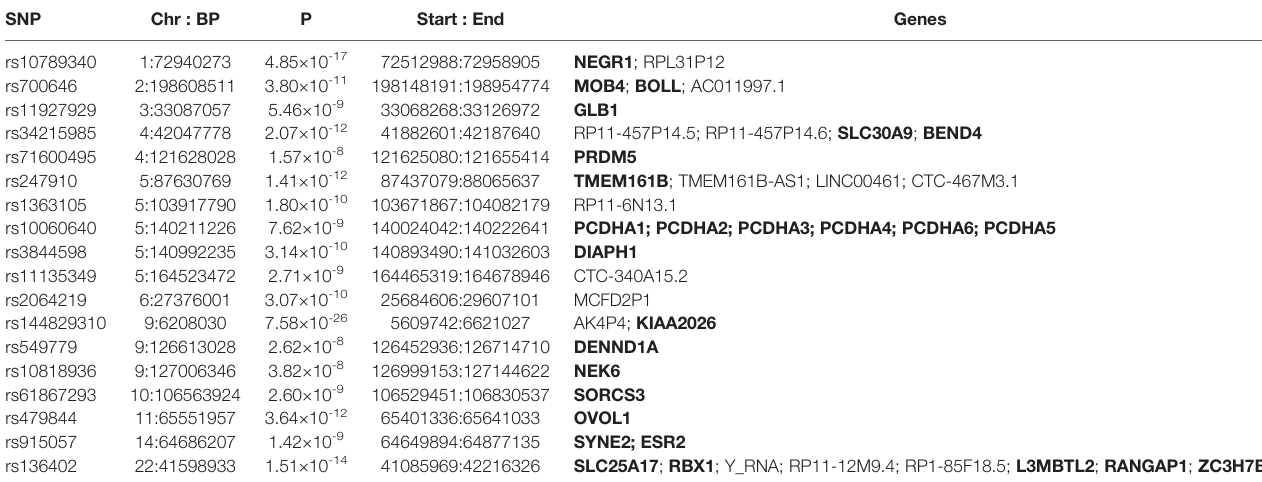
TABLE 1 | Genomic loci shared between MDD and ADs.